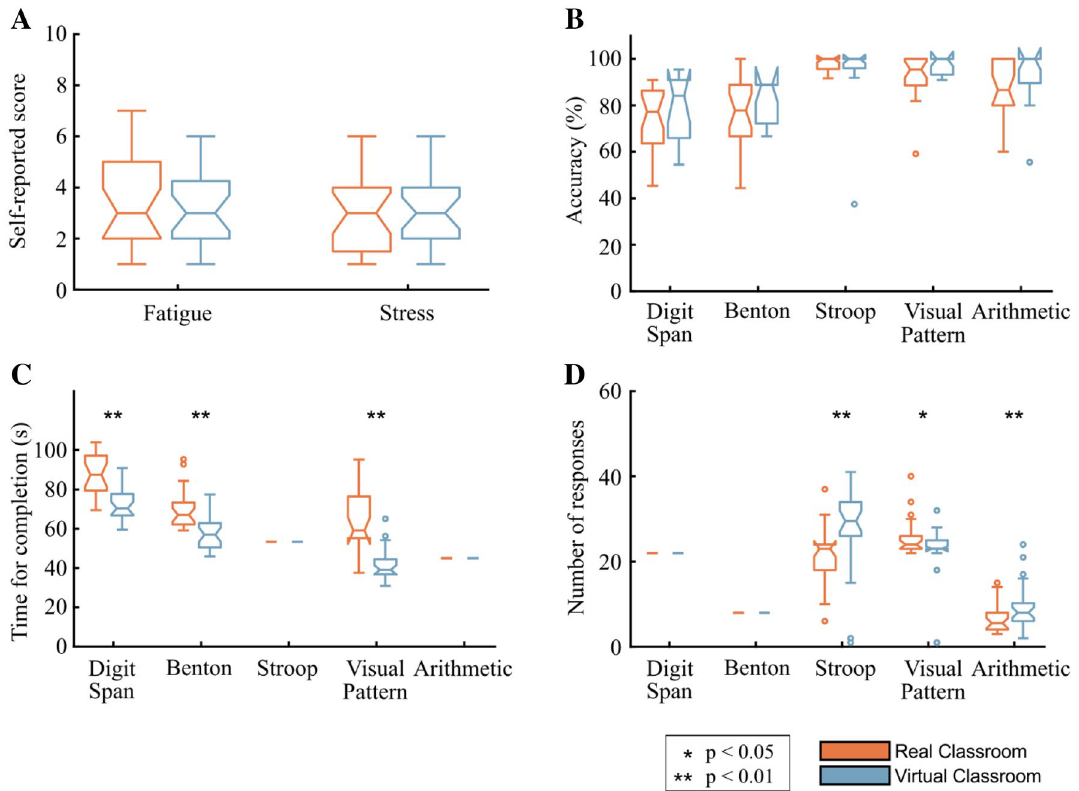
Figure 2. Cognitive test performance in the physical classroom environment vs. the identical virtual classroom. The color bars indicate the median scores in each environment, with the first and third quartiles shown as error bars. ( A ) Self-reported fatigue and stress levels after completing the tests, ( B ) the ratio of correct responses to total number of responses given by the participants, ( C ) the time required to complete each test, and ( D ) the total number of responses given by the participants in each